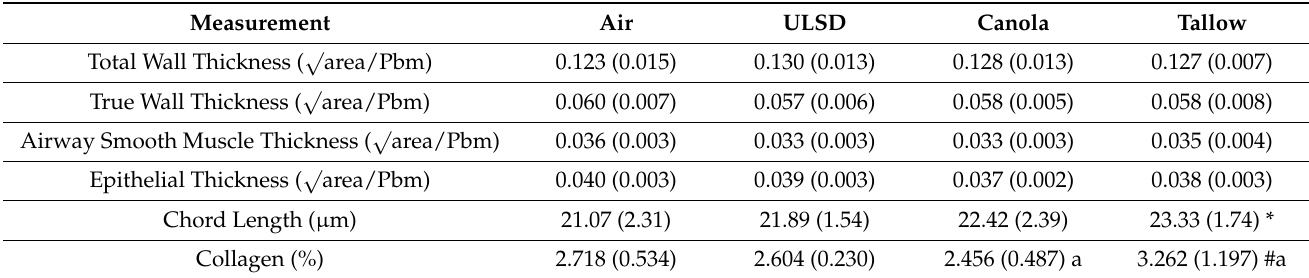
Table 4. Mean (standard deviation) measurements for airway morphology and chord length and collagen % for mice exposed to Air, ULSD, Canola, or Tallow biodiesel exhaust for 2 hr/day for 8 days ( n = 10–12 for all measurements). Pbm = perimeter of the basement